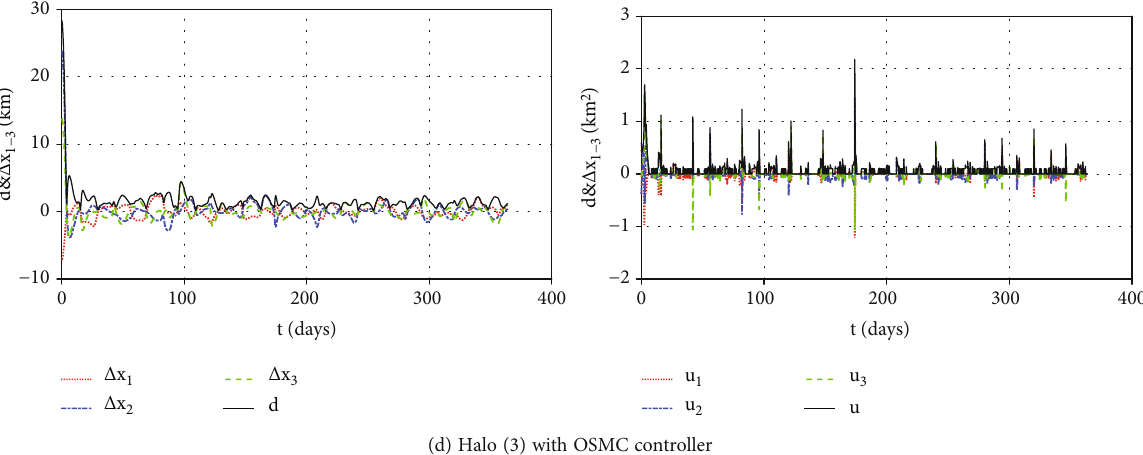
Figure 12: The station-keeping simulations under practical constraints with the Jupiter gravity as the